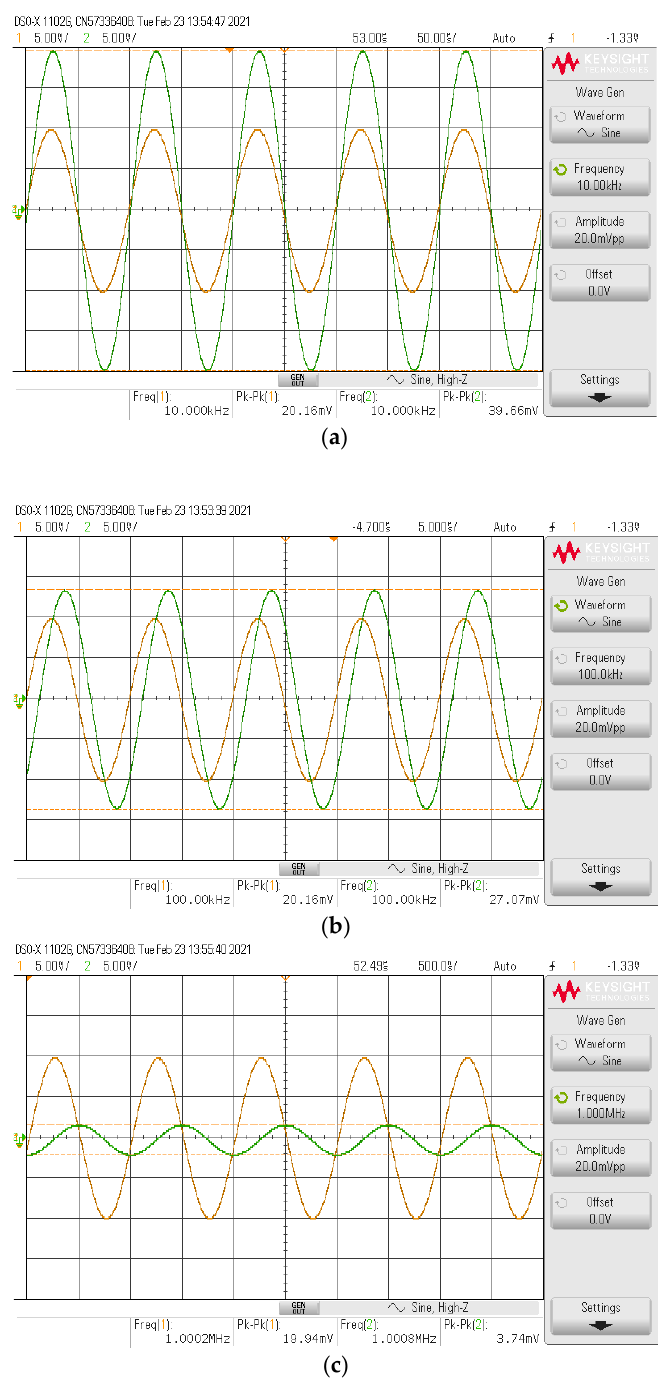
Figure 14. Measured input and output waveform of LP ( ‐‐‐‐ v in , ‐‐‐‐‐ v o ) where I B = 124.5 μ A. ( a ) f = 10 kHz. ( b ) f = 100 kHz. ( c ) f = 1 MHz.